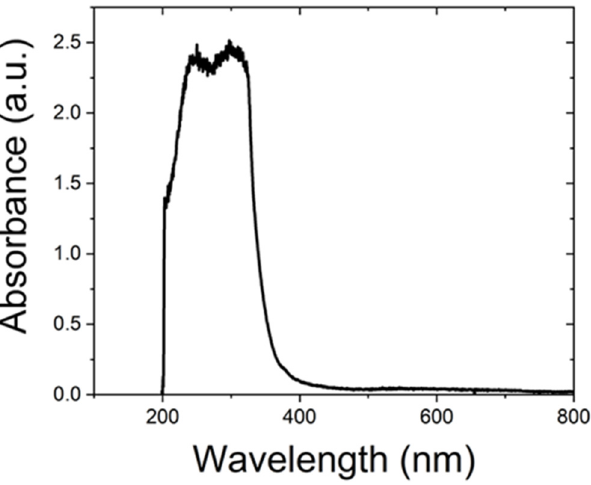
Figure 5. The result of UV-Vis absorption spectra of deltamethrin pesticides.